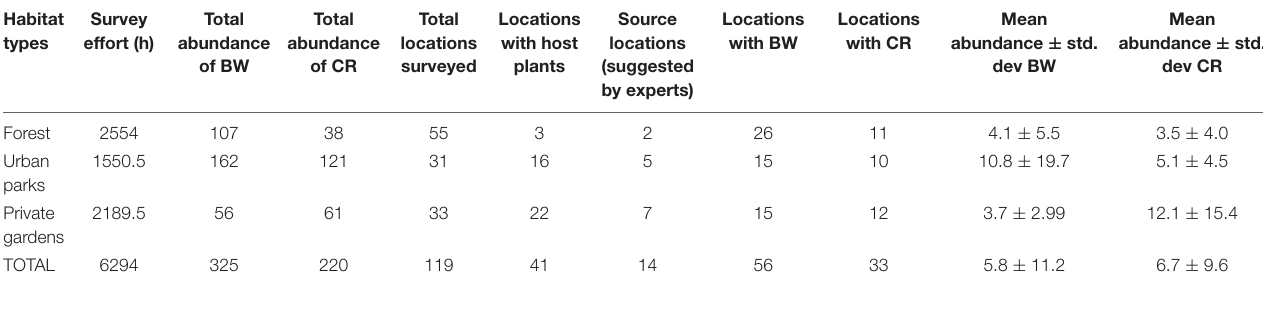
TABLE 1 | Abundance (number of sightings) of Common Birdwing (BW) and Common Rose (CR), presence of host plants and source locations across habitat types between years 1999 and 2019. Habitat